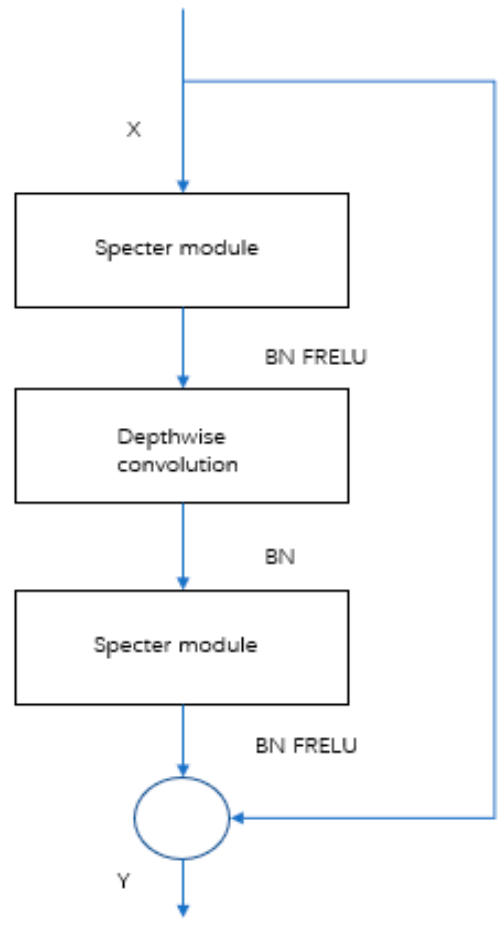
Figure 9. Specter Figure 9. Specter bottleneck.